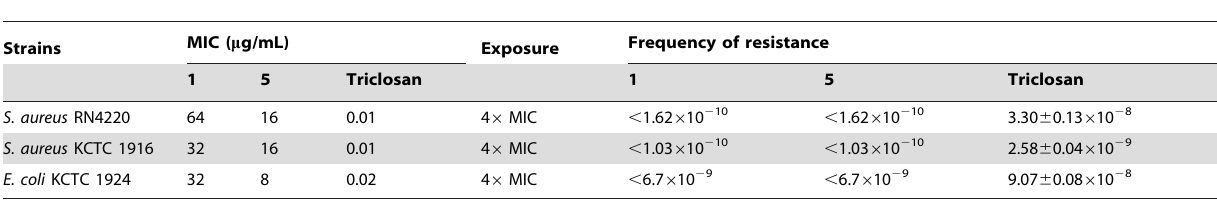
Table 3. Frequency of resistance to meleagrin ( 1 ) and its more active derivative.